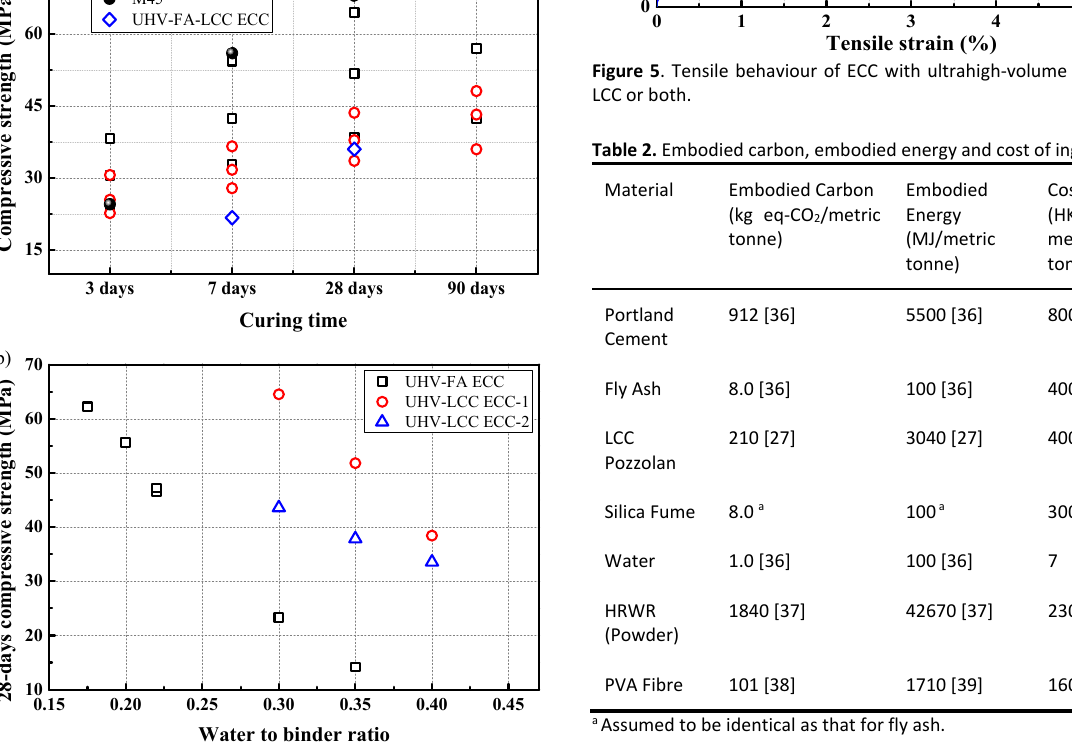
Figure 4 . Compressive strength of ECC with different (a) curing time and (b) water ‐ binder ratio. Material Sustainability of ECC